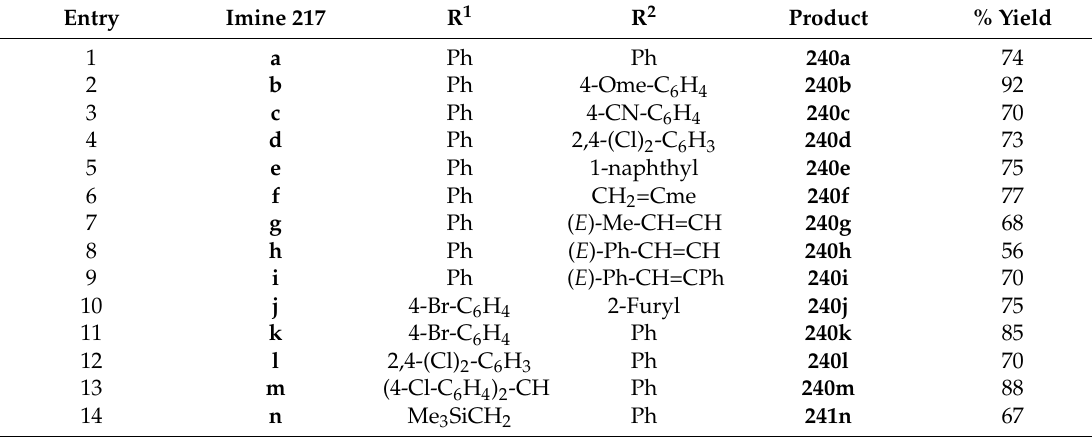
Table 32. Intramolecular cycloaddition of ylide and carbonyl esters within 5d yielding epoxybenzodiazepines 240 (Scheme 68) 1 .